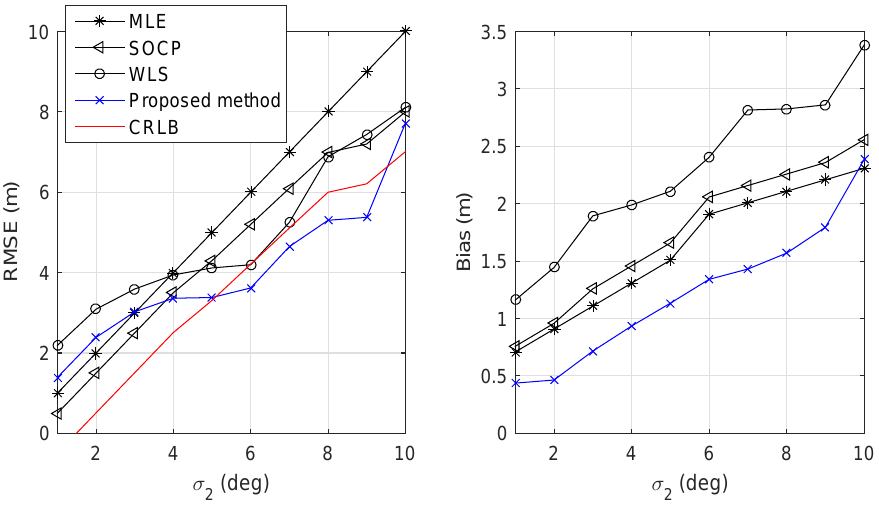
Figure 7. RMSE and bias versus standard deviation of AoA measurement errors σ 2